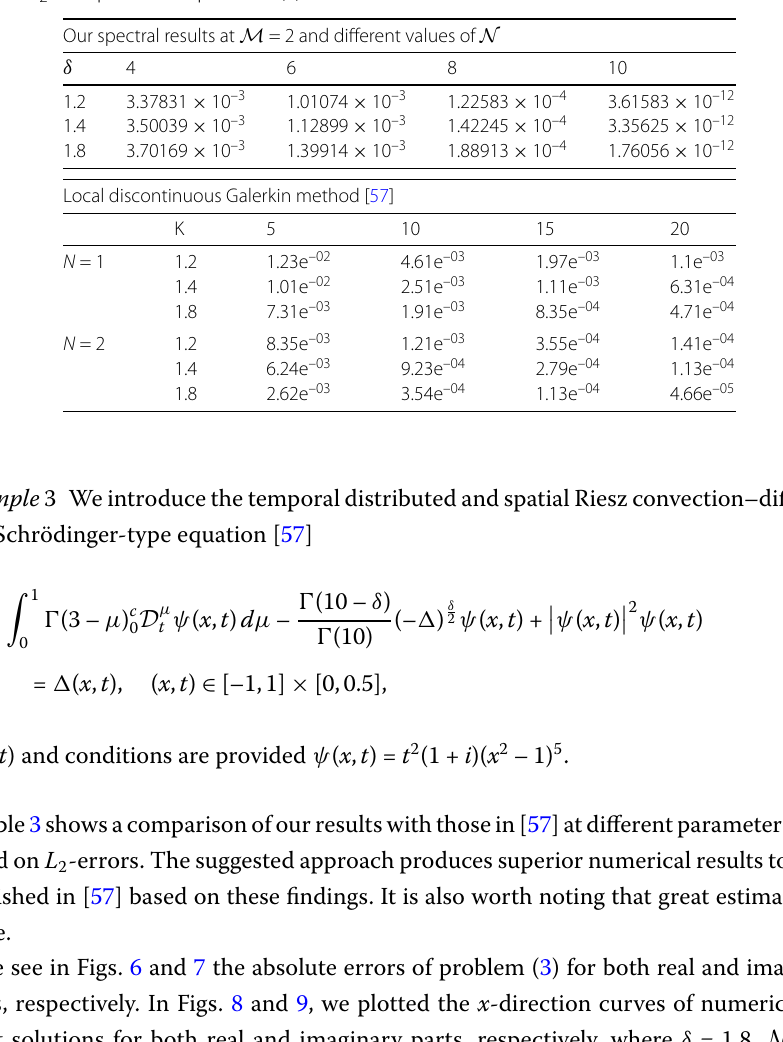
Table 3 L 2 -comparison for problem